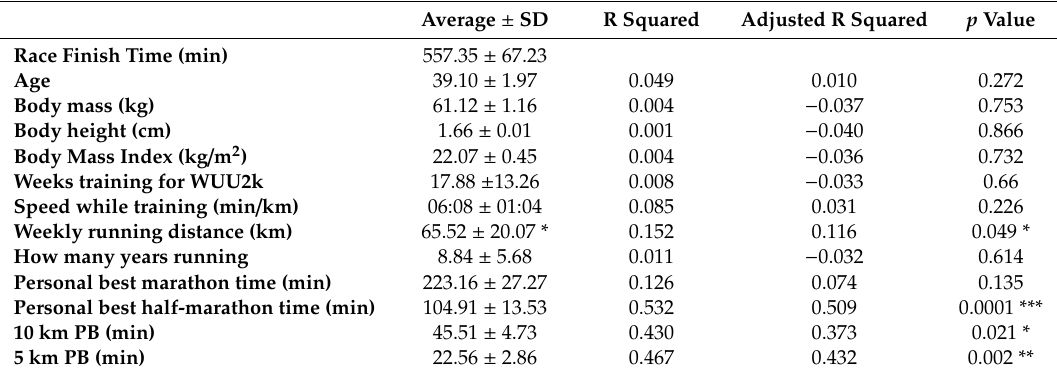
Table 1. Female bivariate analysis (n = 26). Wellington Urban Ultramarathon (WUU), PB (personal best). Average ± SD R